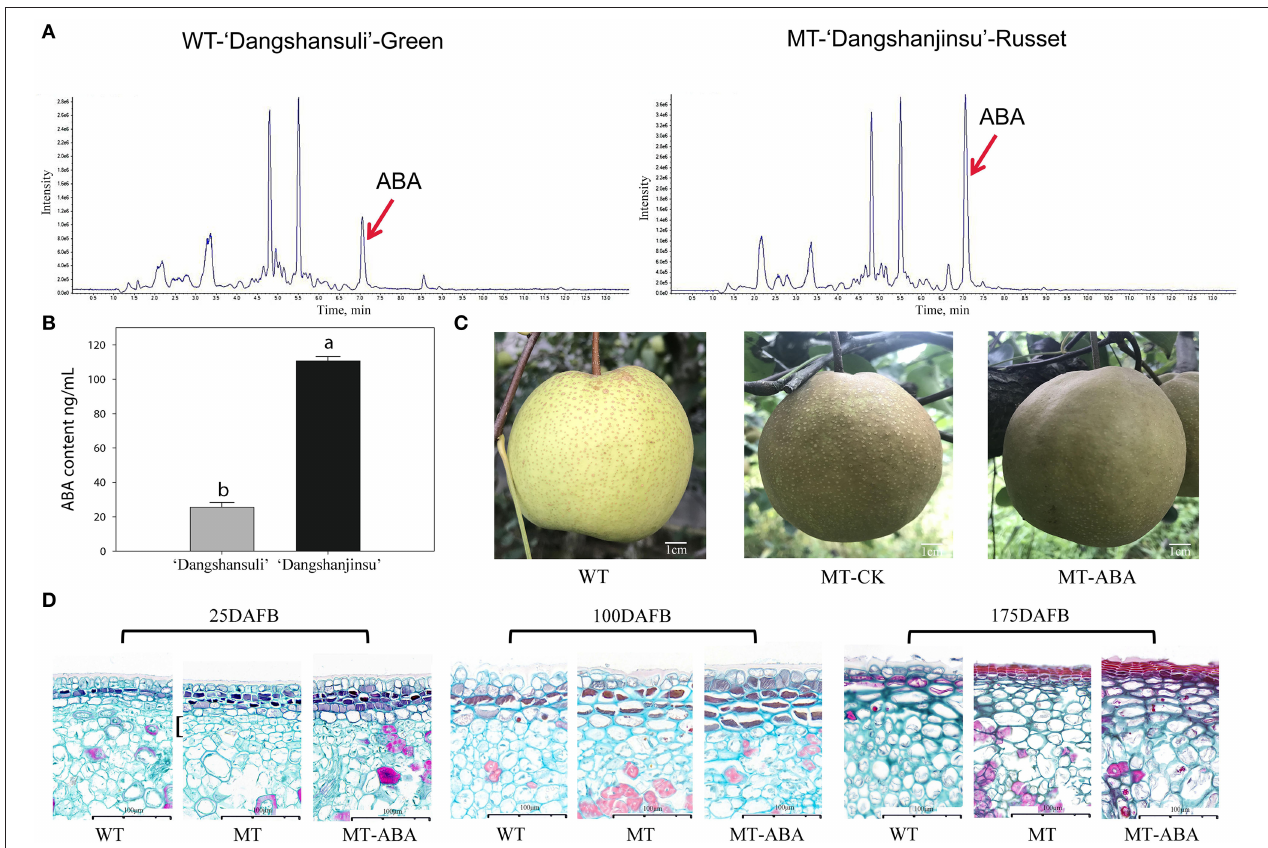
FIGURE 1 | ABA is involved in russet pear skin formation. (A,B) ESI-HPLC-MS/MS analysis of ABA content in russet and green pear skin. (C) Phenotype of ‘Dangshansuli’, ‘Dangshanjinsu’ and ‘Dangshanjinsu’ treated with ABA at 175DAFB. (D) Paraffin slices observation of pear exocarp. Cross section stained with Safranin O-Fast green. The suberized, lignified, and fibrotic cell walls are stained with reddish brown, red, and green, respectively. WT, ‘Dangshansuli’. MT, ‘Dangshanjinsu’. DAFB, days after full bloom. Bars = 100 µ m. The error bars are the means ± SD of three biological repeats and lowercase letters indicate significant differences by two-tailed Student’s t -test ( p <